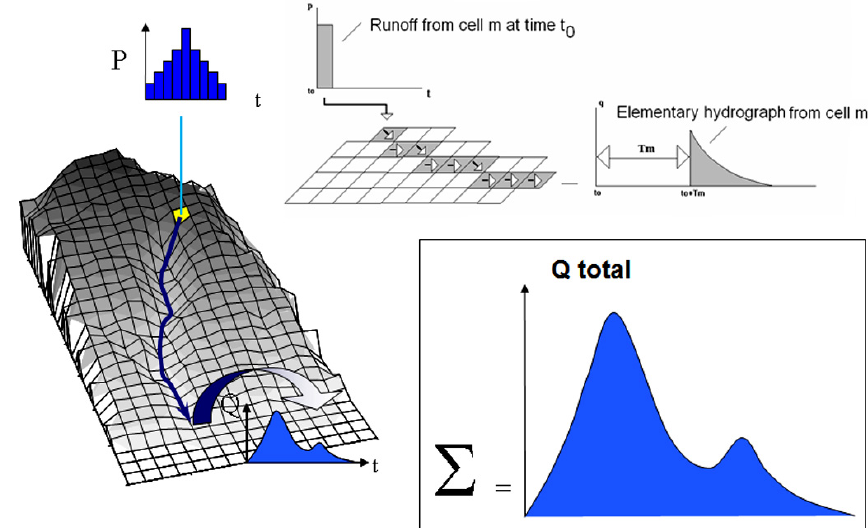
Fig. 1. Diagram of the lag and route routing